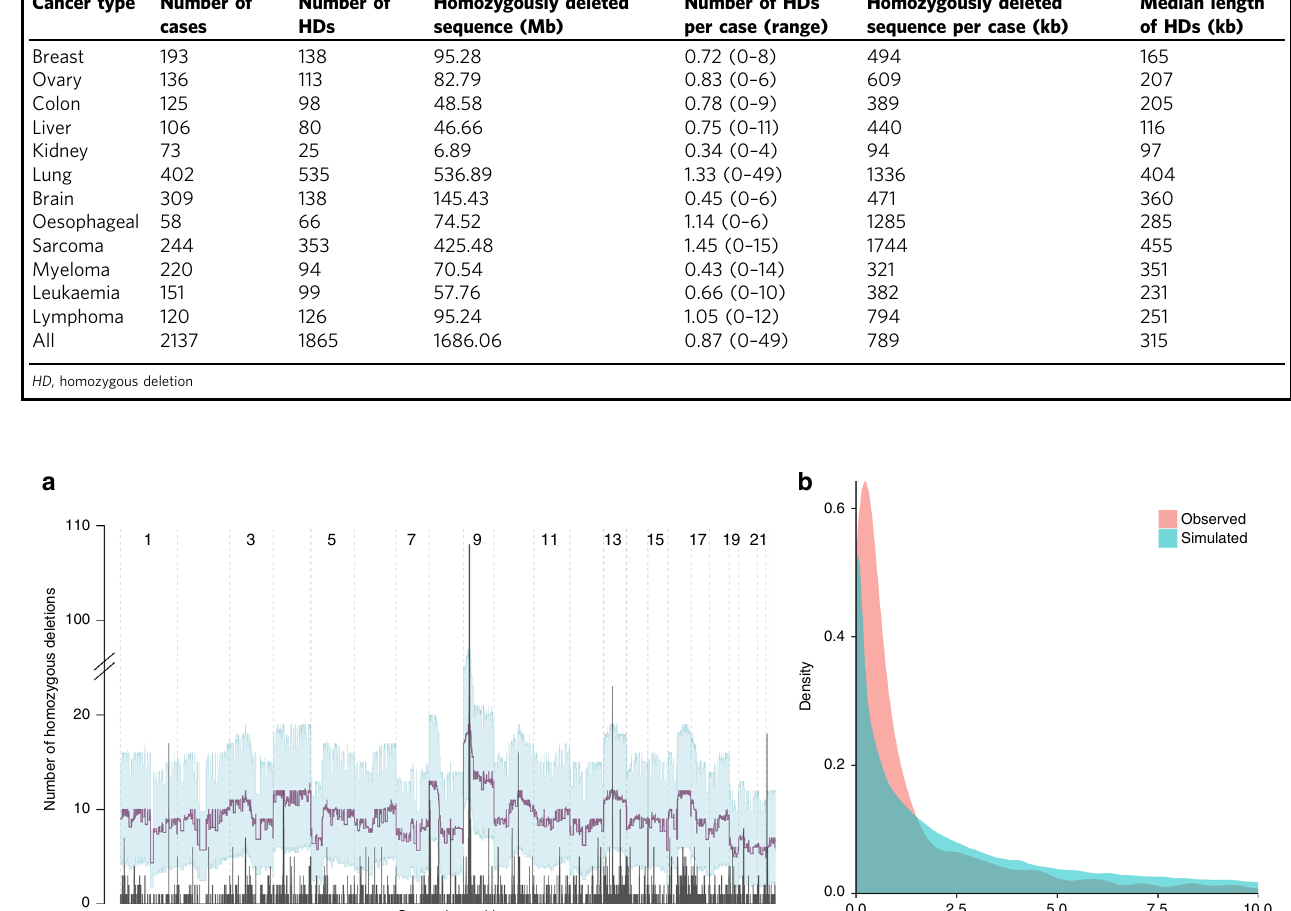
Table 1 Distribution of homozygous deletions across cancer types Cancer type Number of cases